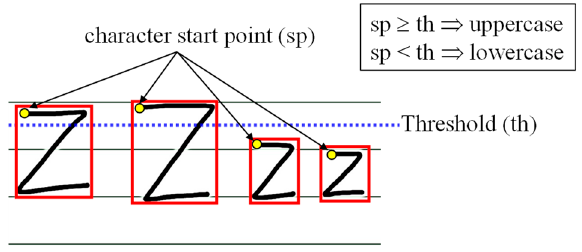
Figure 12. Illustration of uppercase or lowercase determination.